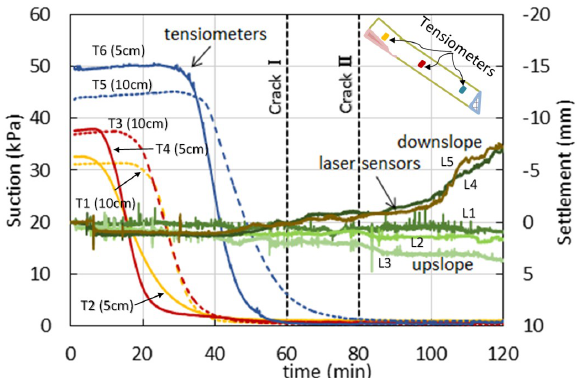
Figure 5. RP2 experiment: Suction and settlement evolution.